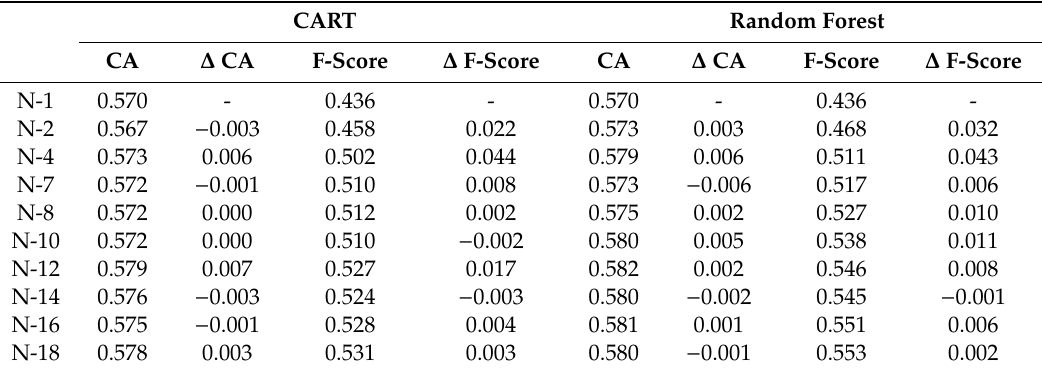
Table 7. Classification accuracy (CA) and F-score of the software maintainability change prediction. Higher values are